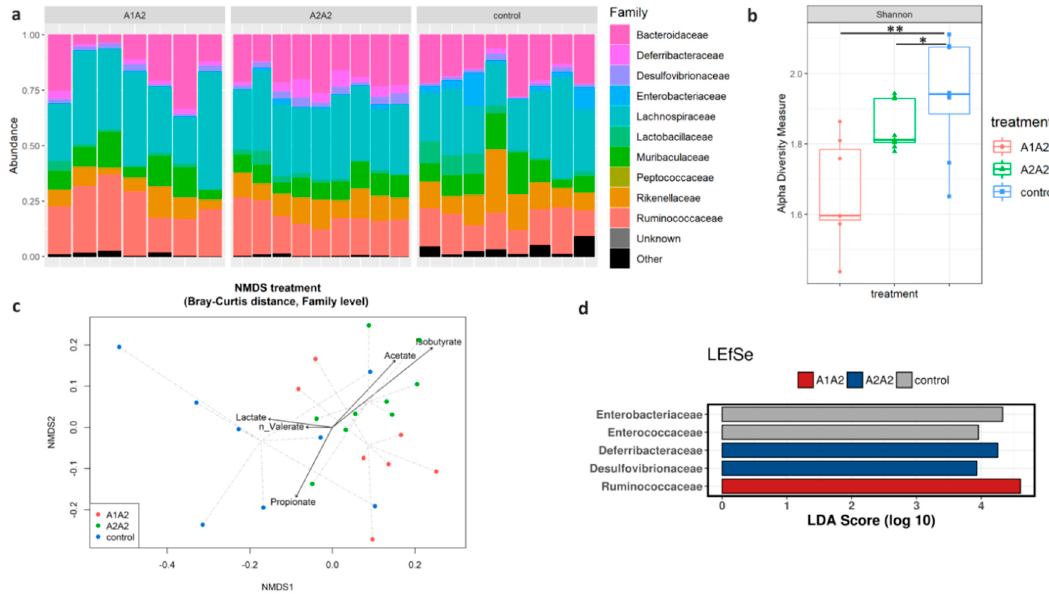
Figure 3. Family level analysis by Next Generation Sequencing (NGS) of faecal samples of mice fed